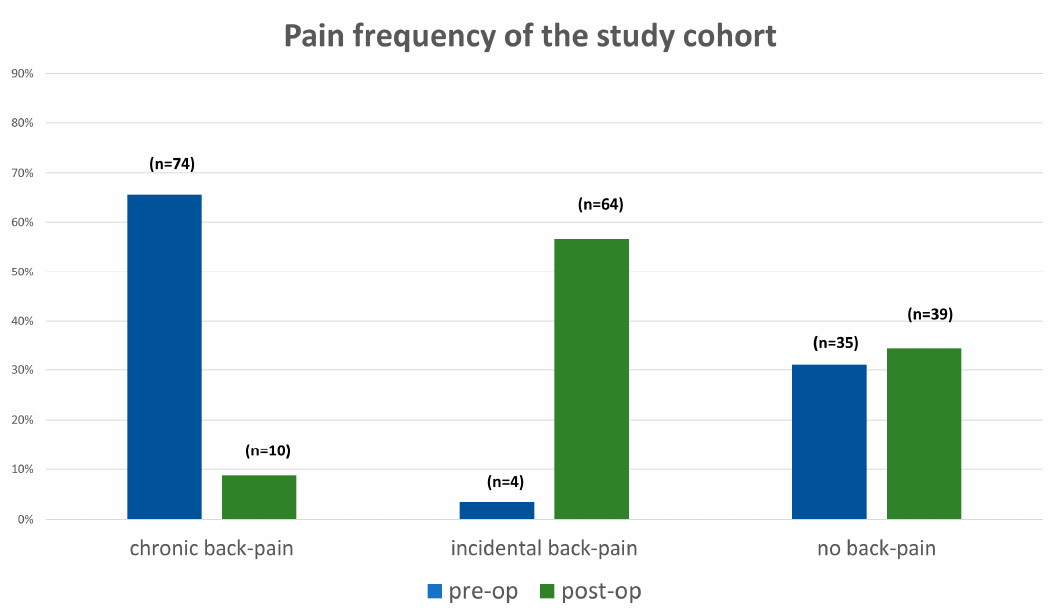
Figure 5. Diagram of back pain frequency pre- and postoperatively for the whole study